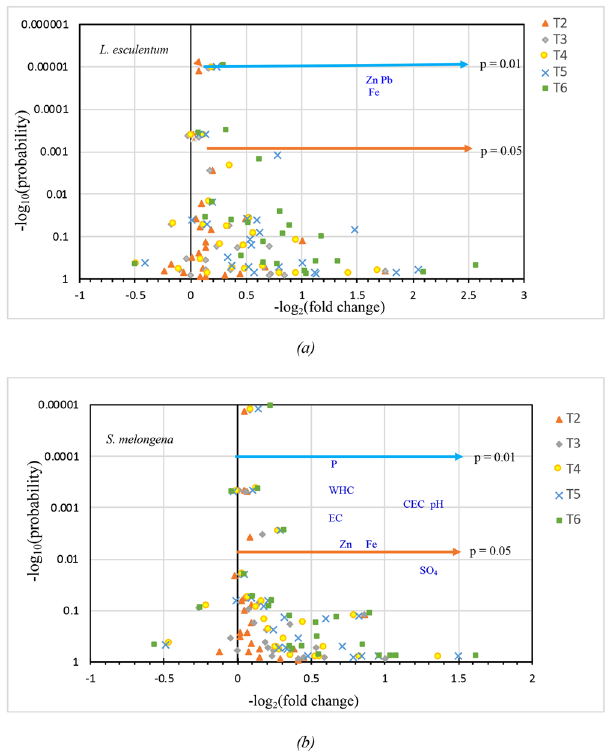
Figure 1. A volcano plot representing the expression of vermicomposted fly ash amended soil parameters under five different treatments scheme. Illustration: The effects of vermicomposted fly ash amended with soil before and after harvesting of Lycopersicon esculentum and Solanum melongena were enumerated by computing the average of treatment T1 (Control) and treatments: T2, T3, T4, T5, and T6. The X-axis represents logarithmic changes in soil physicochemical and nutritional attributes over basic soil, and the Y-axis represents the statistical significance of the difference based on one-way ANOVA considering the effects of a nutrient management scheme. Every individual attribute is displayed as a point. The compounds for which strong statistical differences ( p < 0 . 01 ) were found are presented with names. Av: Available; P: porosity; WHC: water holding capacity; EC: Electrical conductivity; CEC: Cation exchange